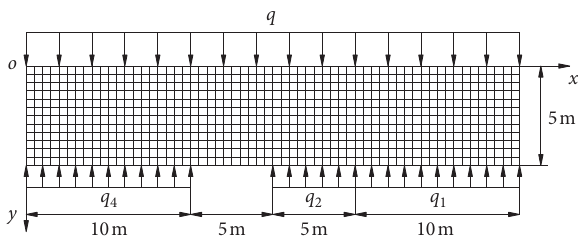
Figure 3: Finite difference elements of the immediate roof in